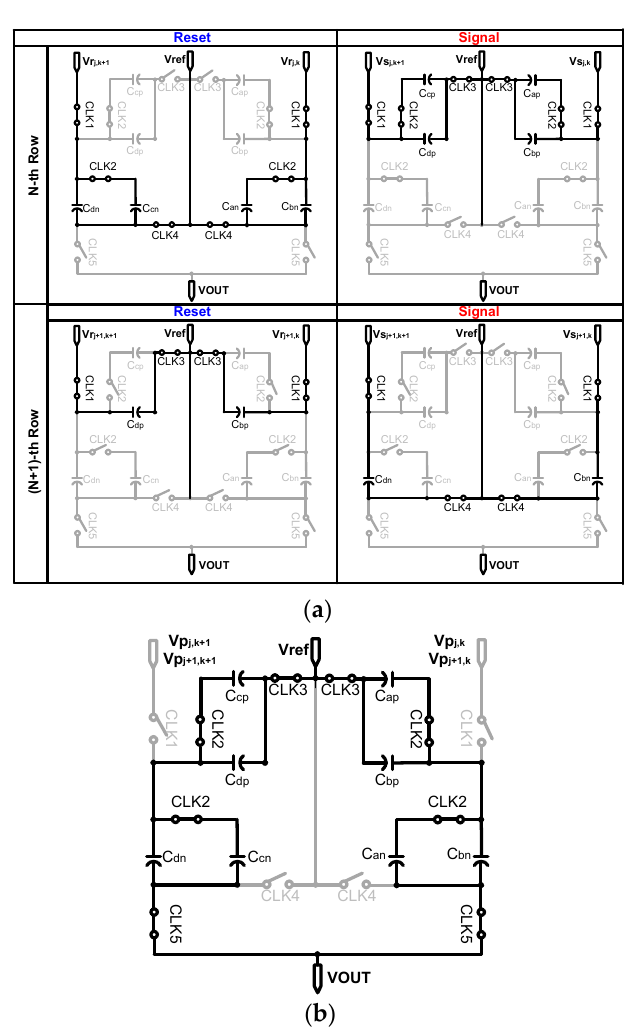
Figure 6. ( a ) The write operation of an analog convolution circuit, and ( b ) the read operation of an analog convolution circuit.